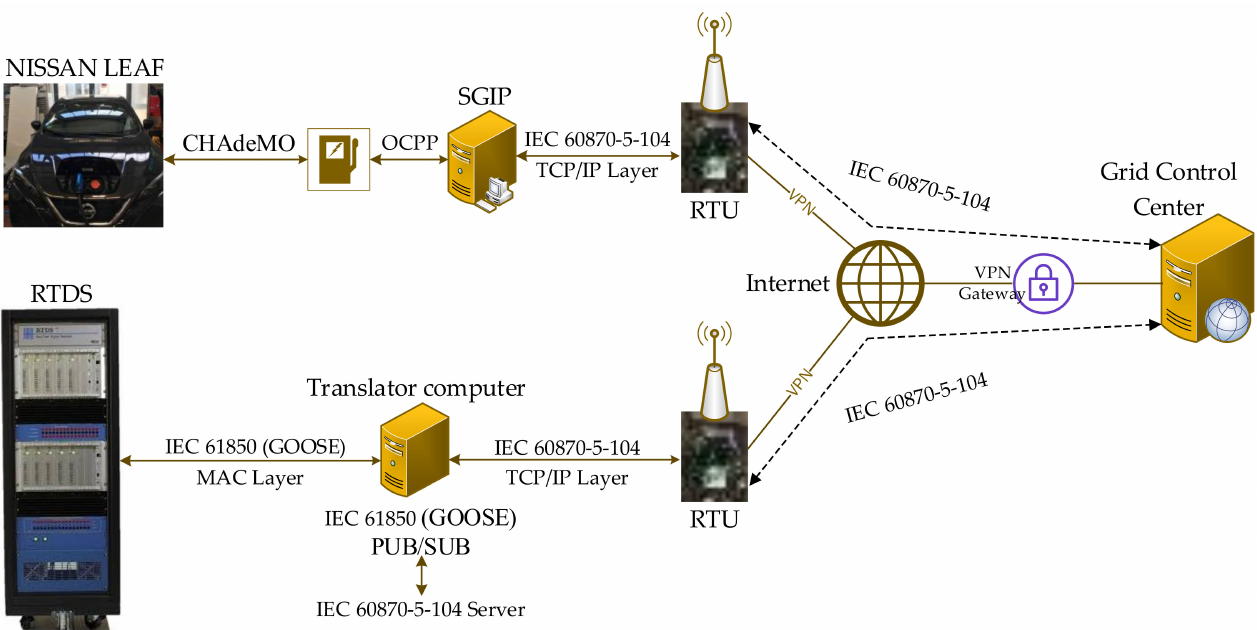
Figure 5. Network connection